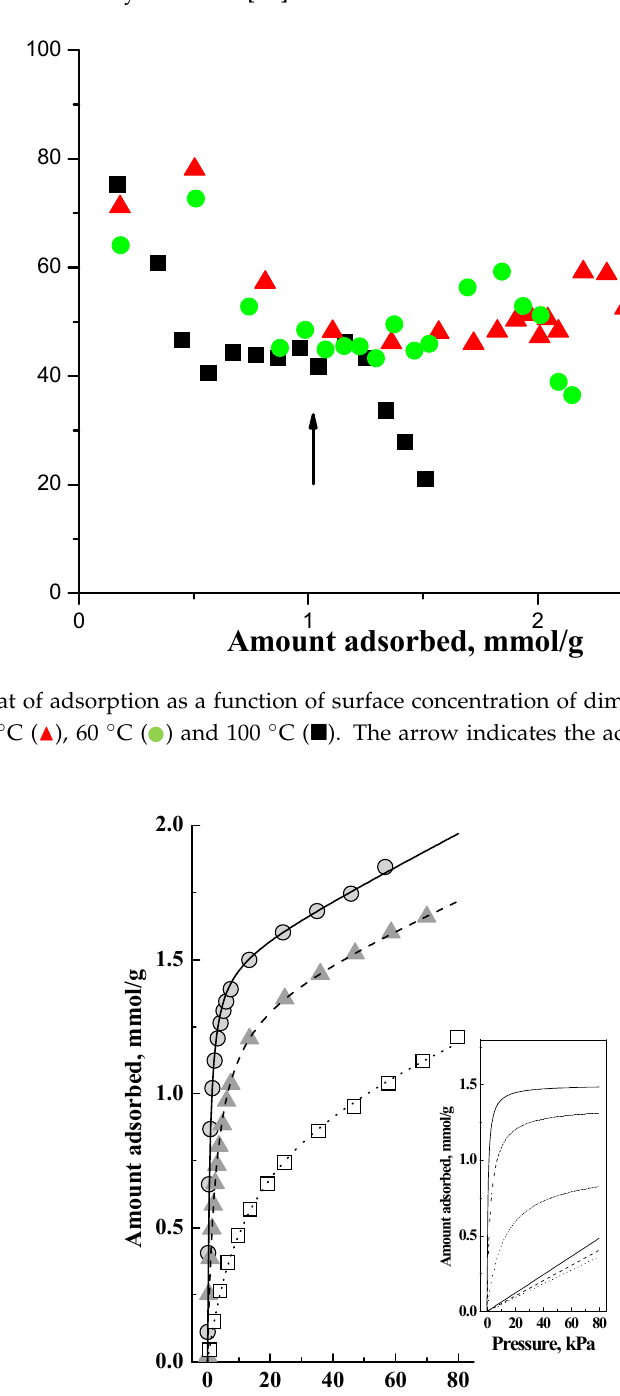
), 60 ◦ C ( (cid:78) ) and (cid:32)